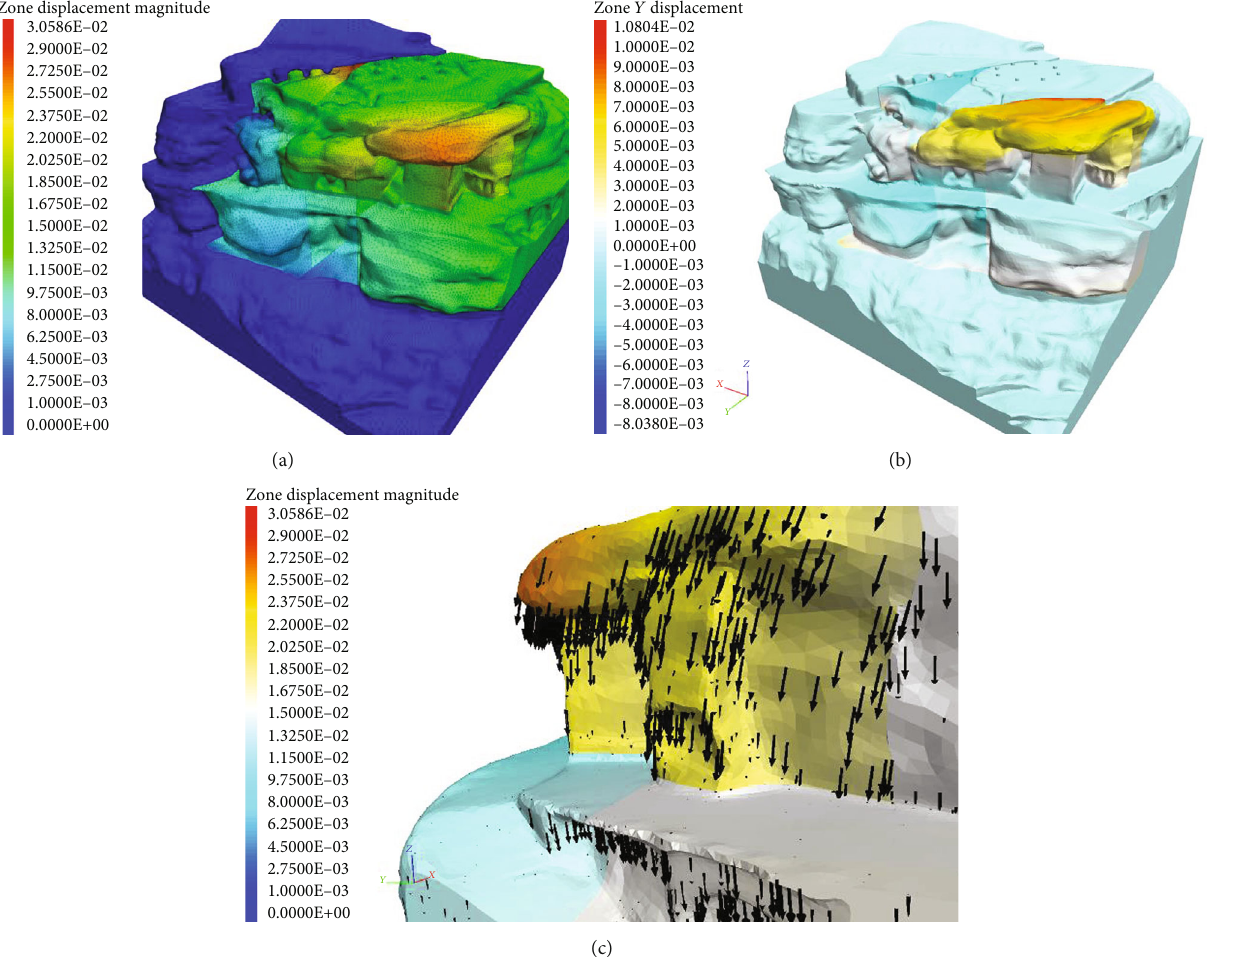
Figure 6: Displacement nephogram contour of surrounding rock: (a) total displacement cloud map; (b) south-north ( Y direction) displacement cloud map; (c) displacement vector fi eld at the corner of the cli ff wall.